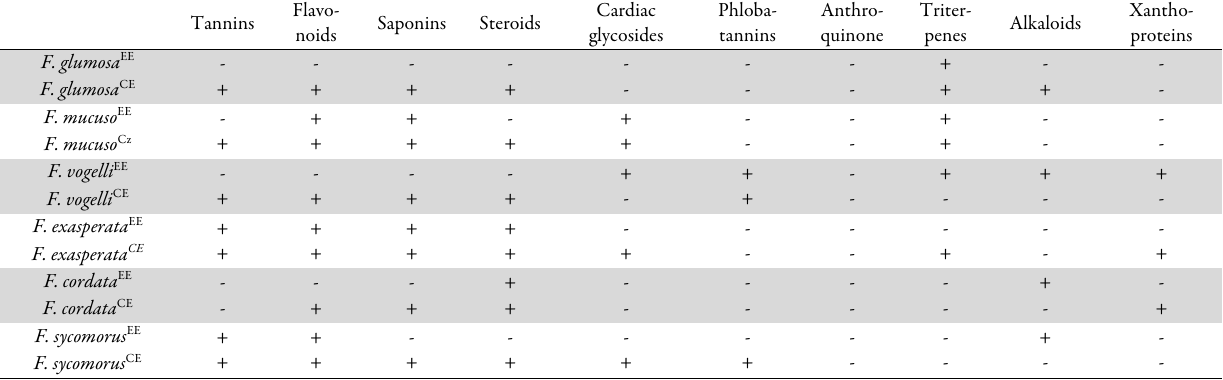
Table 1. Phytochemicals constituents of chloroform and ethanolic leaf extracts of different Ficus species